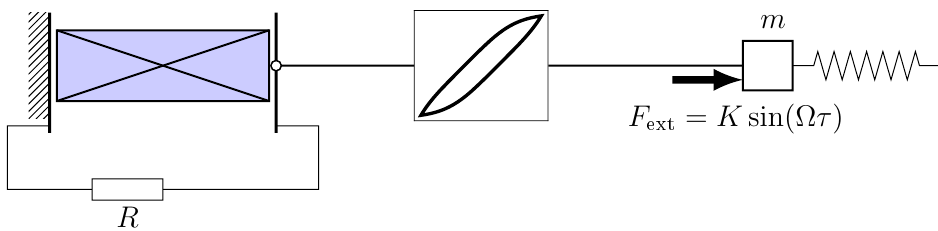
Figure 6. Energy harvester, mechanically connected to the classical oscillator by means of a hysteresis